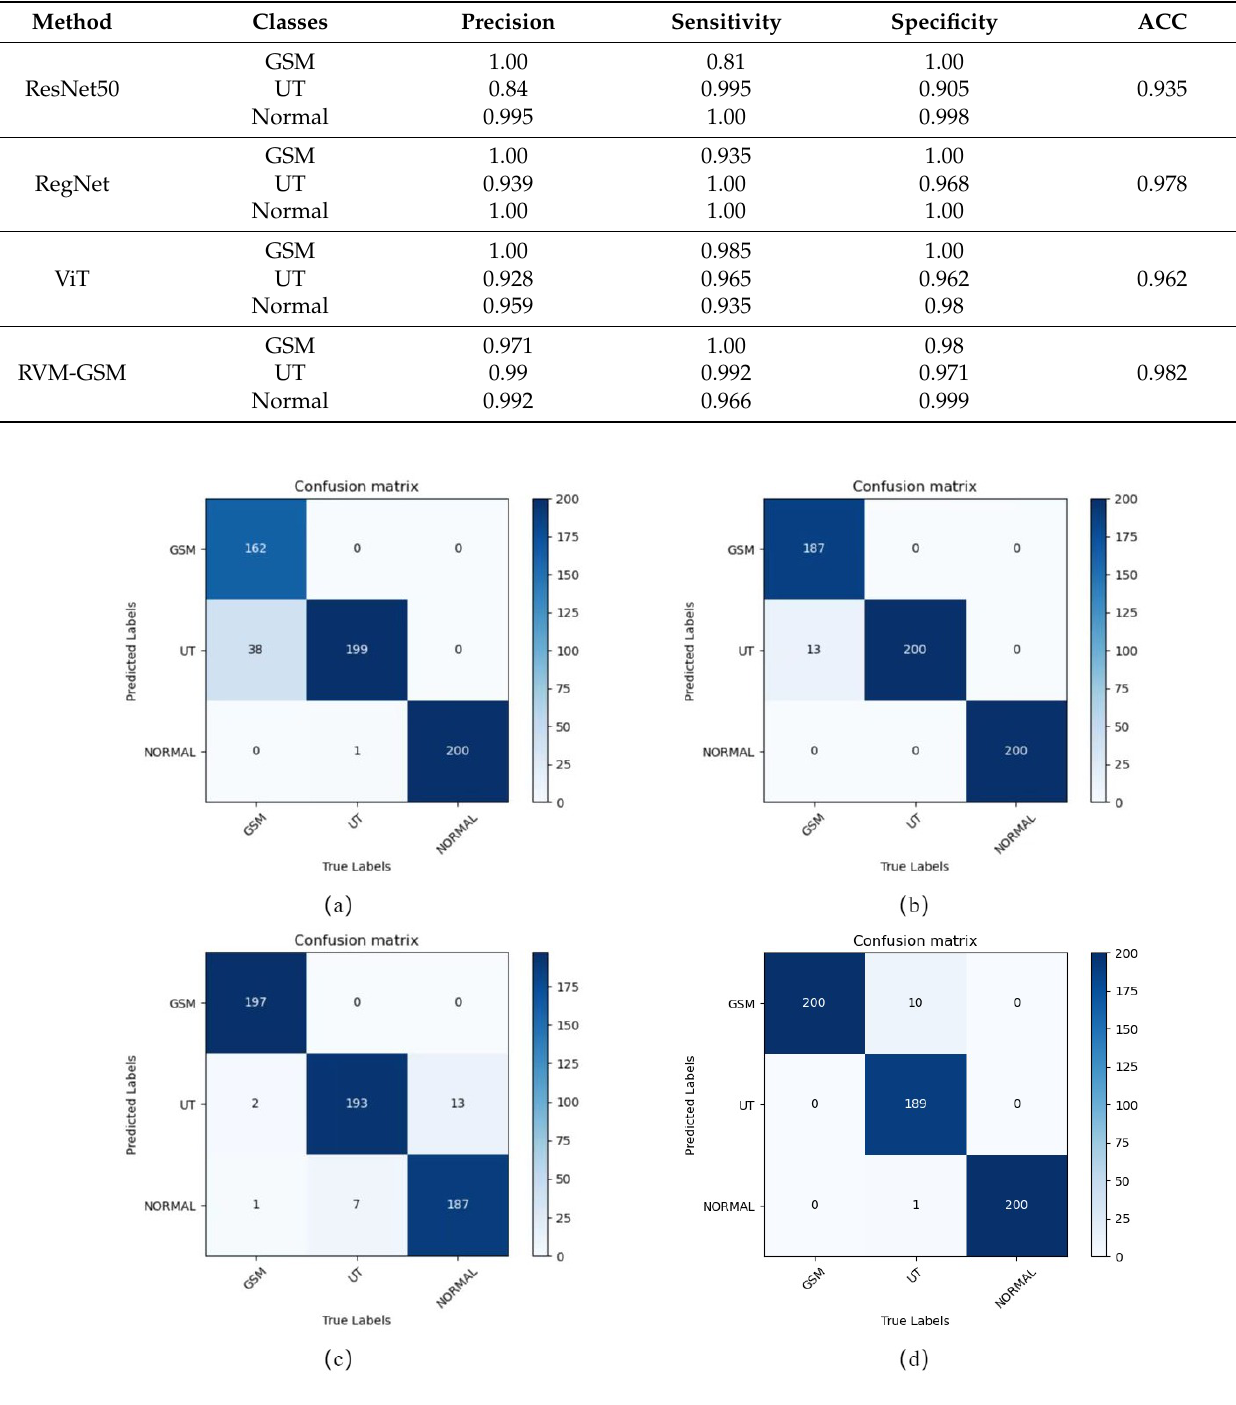
Figure 6. Neural network model confusion matrix. ( a ) ResNet50, ( b ) RegNet, ( c ) ViT, and ( d )